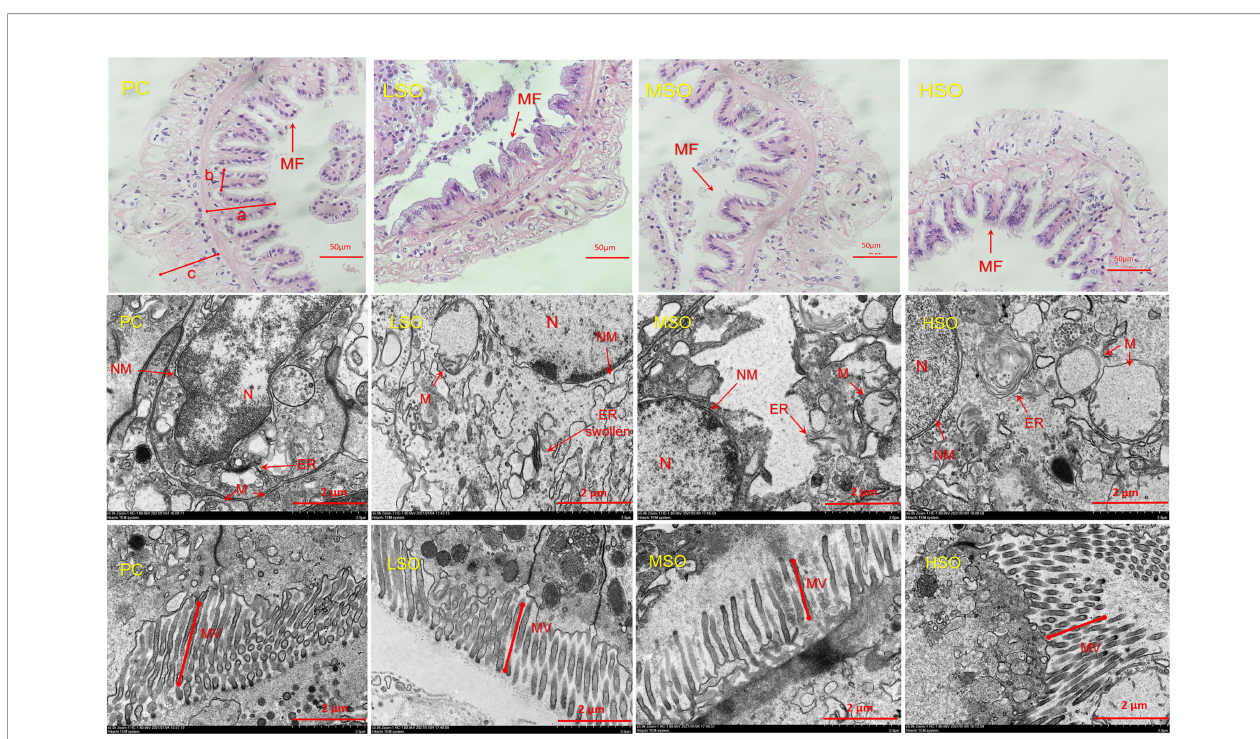
FIGURE 3 | Mid-intestinal morphology (H&E staining and TEM) of shrimp in this study. Note: MF, mucosal folds; a shows height of mucosal folds; b shows width of mucosal folds; c shows thickness of muscle layer; N, cell nucleus; NM, nucleus membrane; M, mitochondria; ER, endoplasmic reticulum; MV, microvilli. Pictures in the same row are considered as the same